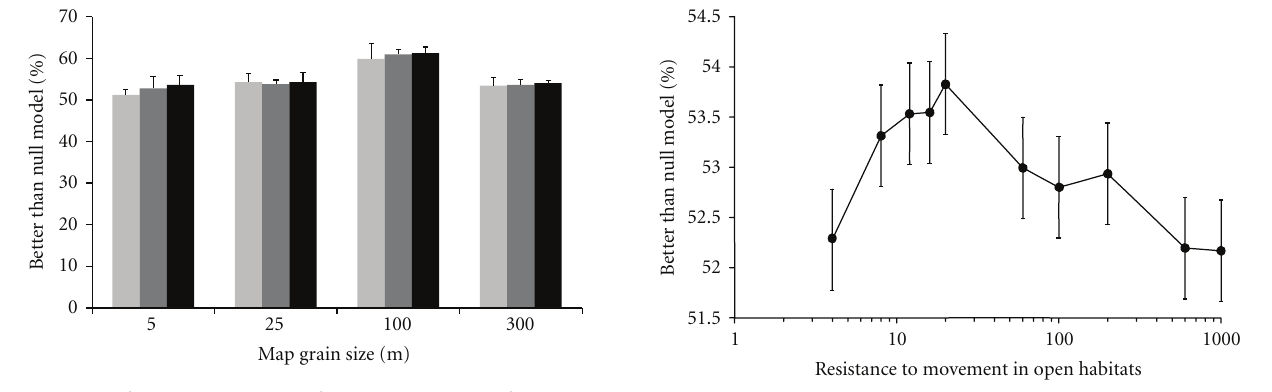
Figure 6: Mean (SE) performance of simulations with 10 move- ment resistances associated with open habitats. Performance was defined as the percentage of the 500 simulation for which mean dis- tance was smaller than median of mean distances for the null model of the corresponding year. Performance estimates were obtained after accounting for forest edge, thematic map resolution and map grain